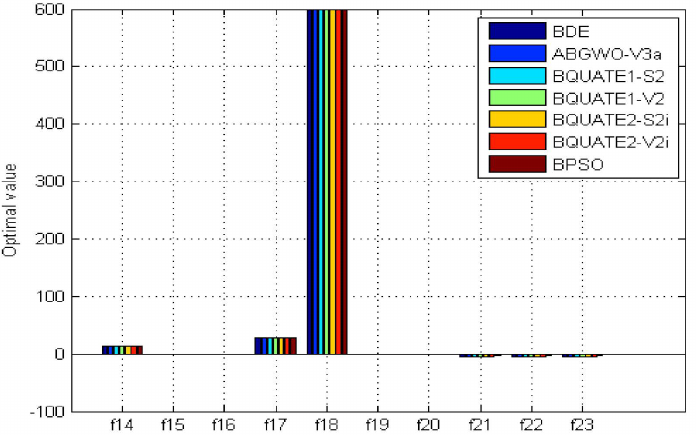
Figure 8. The optimal values of BDE, ABGWO-V3a, BQUATE1-S2, BQUATE1-V2, BQUATE2-S2i, BQUATE2-V2i, and BPSO on